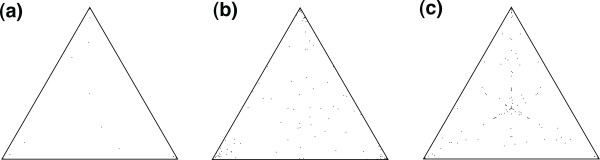
Example of likelihood mapping categories. (a), category 1 genes with strong phylogenetic signal the example given here is the ZP2 gene, (b) category 2 genes with intermediate levels of phylogenetic signal, the example given here is the Prkar2a gene, and (c), category 3 genes with low/no phylogenetic signal, the example given here is the CD9 gene.